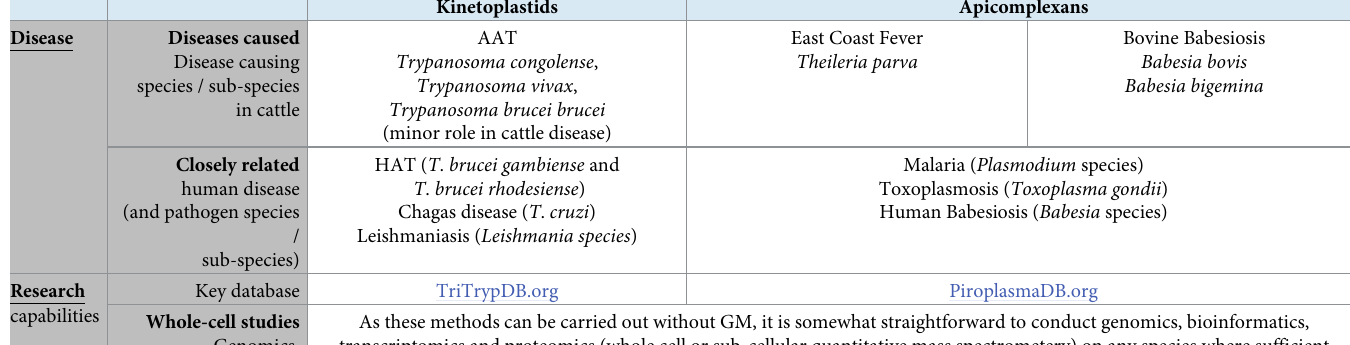
Table 1. Research methods used for the study of human disease–causing parasite species that could be applied to cattle disease–causing parasites [2–9]. Note that the nonhuman infective subspecies of T . brucei ( T . b . brucei ) is the most widely used African trypanosome in the laboratory, acting as a model system for the human-infec- tive subspecies T . b . rhodesiense and T . b . gambiense . Example studies are not exhaustive of the available